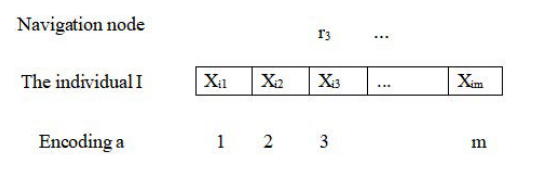
Fig. 2 Individual code